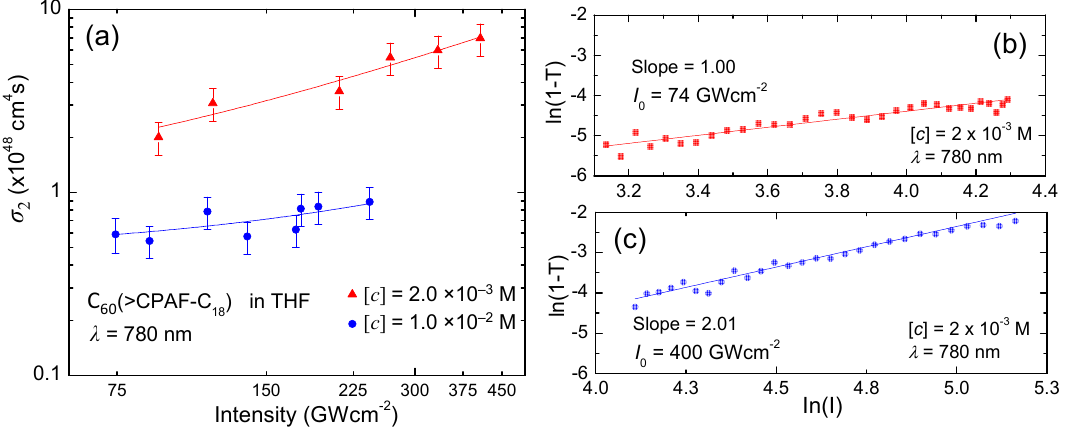
Figure 6. ( a ) Effective two photon absorption cross sections of C 60 (>CPAF-C 18 ) plotted as a function of pulse laser intensities; ( b ) and ( c ) show the plot of ln(1 ‒ T) vs. I for the same compound with different intensities I o at the focal point.